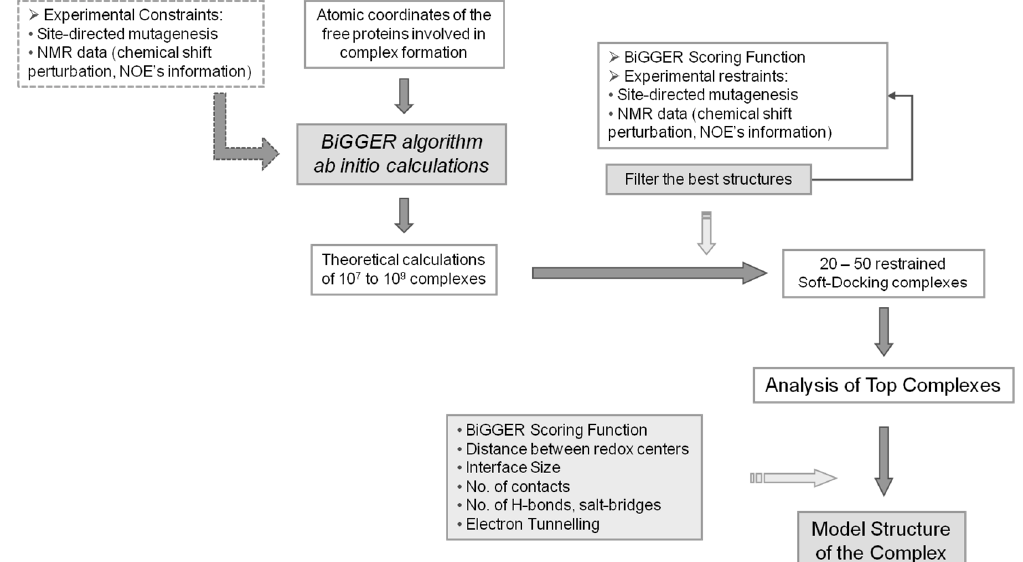
Figure 3. BiGGER Docking Process. Diagram explaining the approach used in molecular docking simulations using BiGGER. The atomic coordinates of the free proteins are entered into the protein docking algorithm [24]. Initial ab initio calculations by BiGGER produce 10 7 to 10 9 complexes, which are filtered and scored according to BiGGER Scoring function and 1000 putative docked positions are retained. These complexes are then scored and ranked using experimental restraints (e.g., NMR chemical shift perturbation). The highest ranked complexes are analyzed and a model structure for the complex is obtained. Adapted from Morelli, et al. [48].